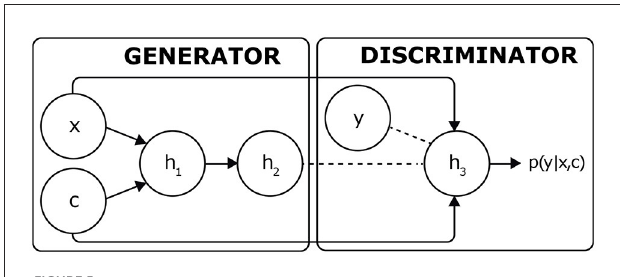
FIGURE5 Application of GANs to a task of type p ( y | x , c ). By interacting with the discriminant, the generator is trained to reconstruct the output datum y via the synthetic datum h 2 .